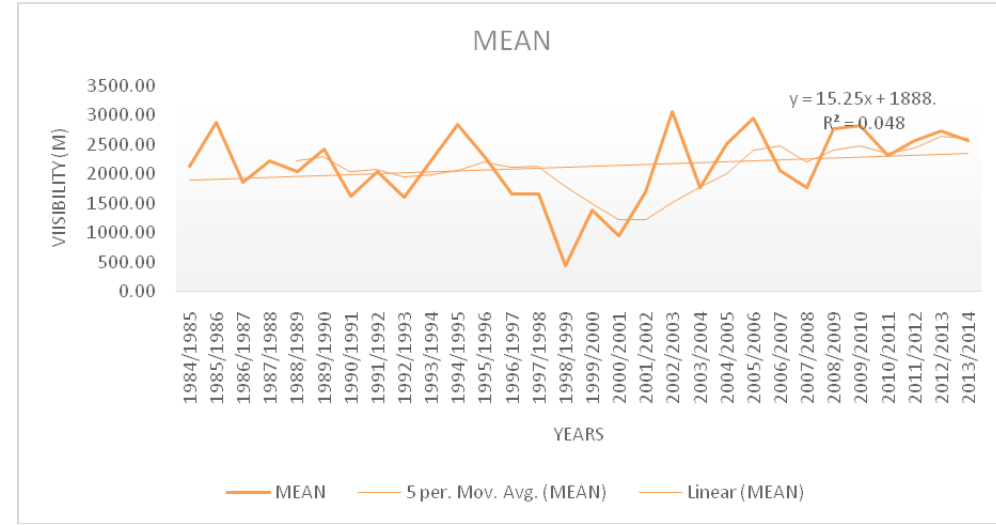
Figure 3: Seasonal mean distribution and trend of visibility for Bauchi station (1984-2014).